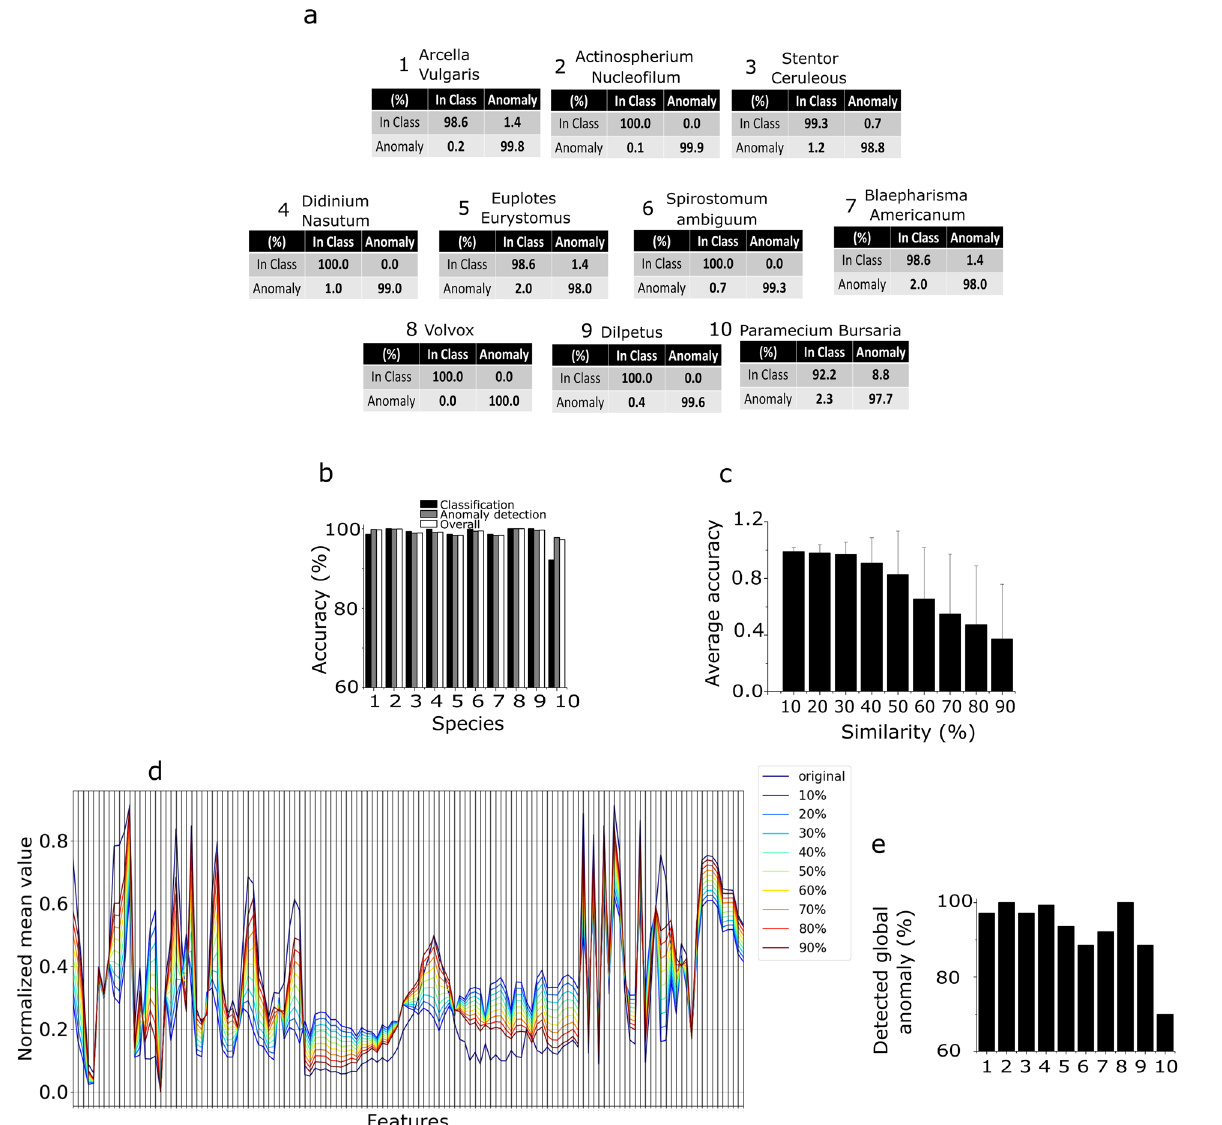
Figure 4. Delta-enhanced class detector performances and results. a Confusion matrix corresponding to each of the ten neural networks trained on the lensless microscope dataset. b Overall testing accuracy performances for each of the ten testing classes. The number used on x axis to label each species correspond to the species number in panel a . c , d DEC detector anomaly detection performances tested on in silico generated data. c Testing accuracy performances for varying percentage values of in silico species similarity with the trained species. d Example of average features space parallel coordinates plot for the in-silico species obtained using the species Spirostomum Ambiguum . By increasing the similarity, the features of the surrogate species approach the features of the real species, resulting in an increased average anomaly misclassification rate, decreasing the overall accuracy levels. e Detection of unknown species. The panel shows the percentage of samples detected by all the DEC detectors as anomaly, when removing one training species from the set, for each of the ten training species. These numbers reflect the level of accuracy of the proposed algorithm in detecting unseen species. The number used on x axis to label each species correspond to the species number in panel a